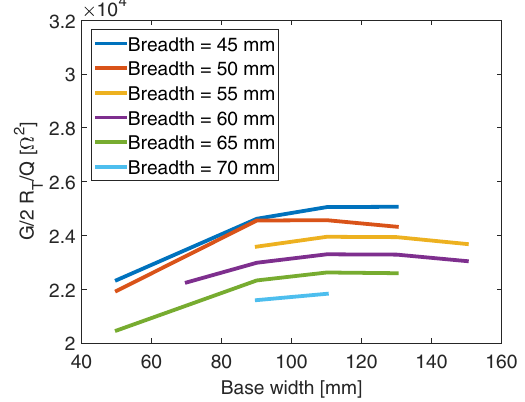
R FIG. 6. G vs base width for different values of base breadth. 2 Q The tip width and breadth were fixed at 45 mm and 40 mm, respectively.